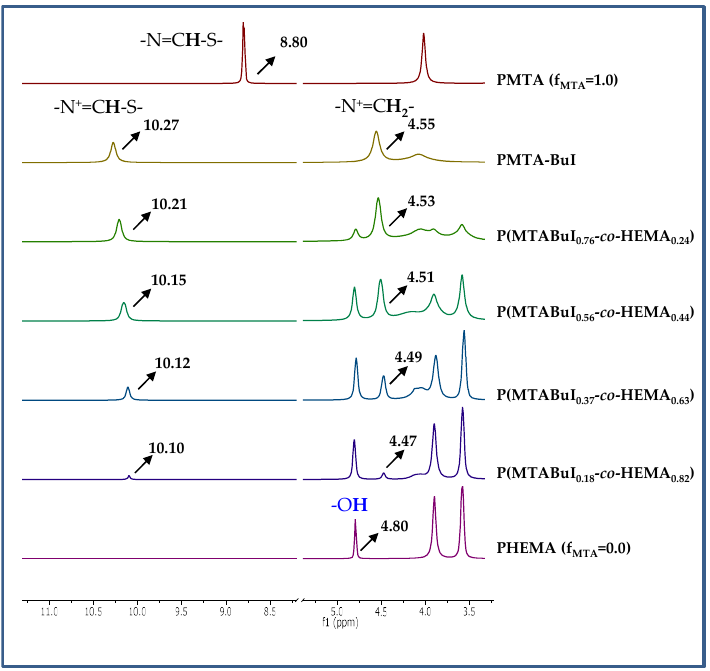
Figure 1. Schematic representation of the preparation of the P(MTARI-co-HEMA) polycations by quaternization with alkyl iodide (RI). Representative region of 1 H-NMR spectra in DMSO-d6 of P(MTABuI- co -HEMA), PMTA, PMTABuI, and PHEMA.